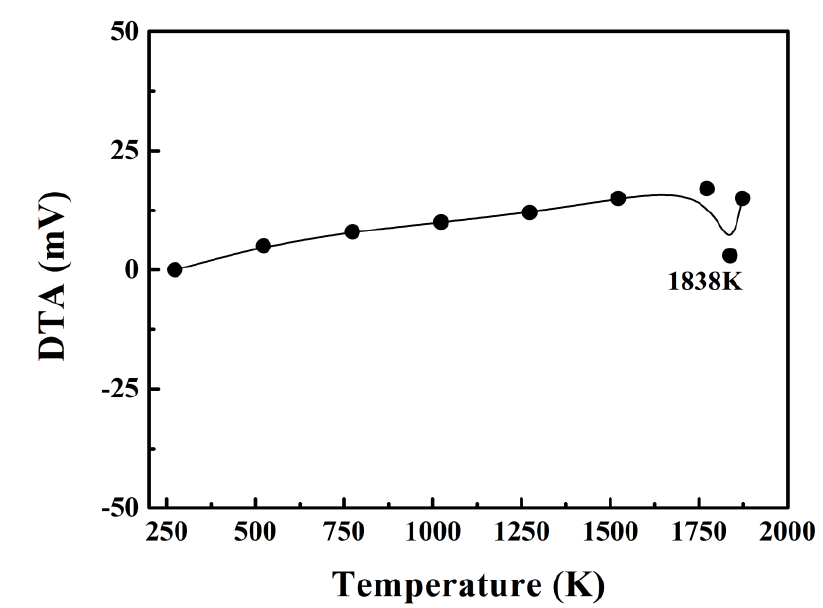
Figure 2. Relationship between graphene content and the mixing uniformity of powders.